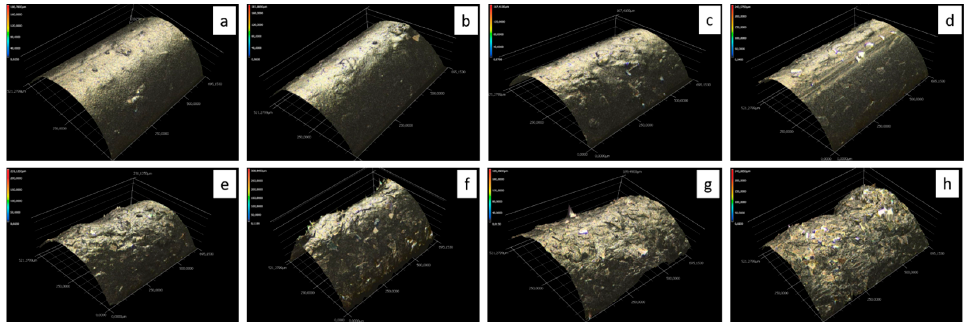
Figure 3. 3D laser microscopy images of monofilament coated with carbon silicone and Ag352000, ( a ) 5%, ( b ) 10%, ( c ) 15%, ( d ) 20%, ( e ) 25%, ( f ) 30%, ( g ) 35%, ( h ) 40%.